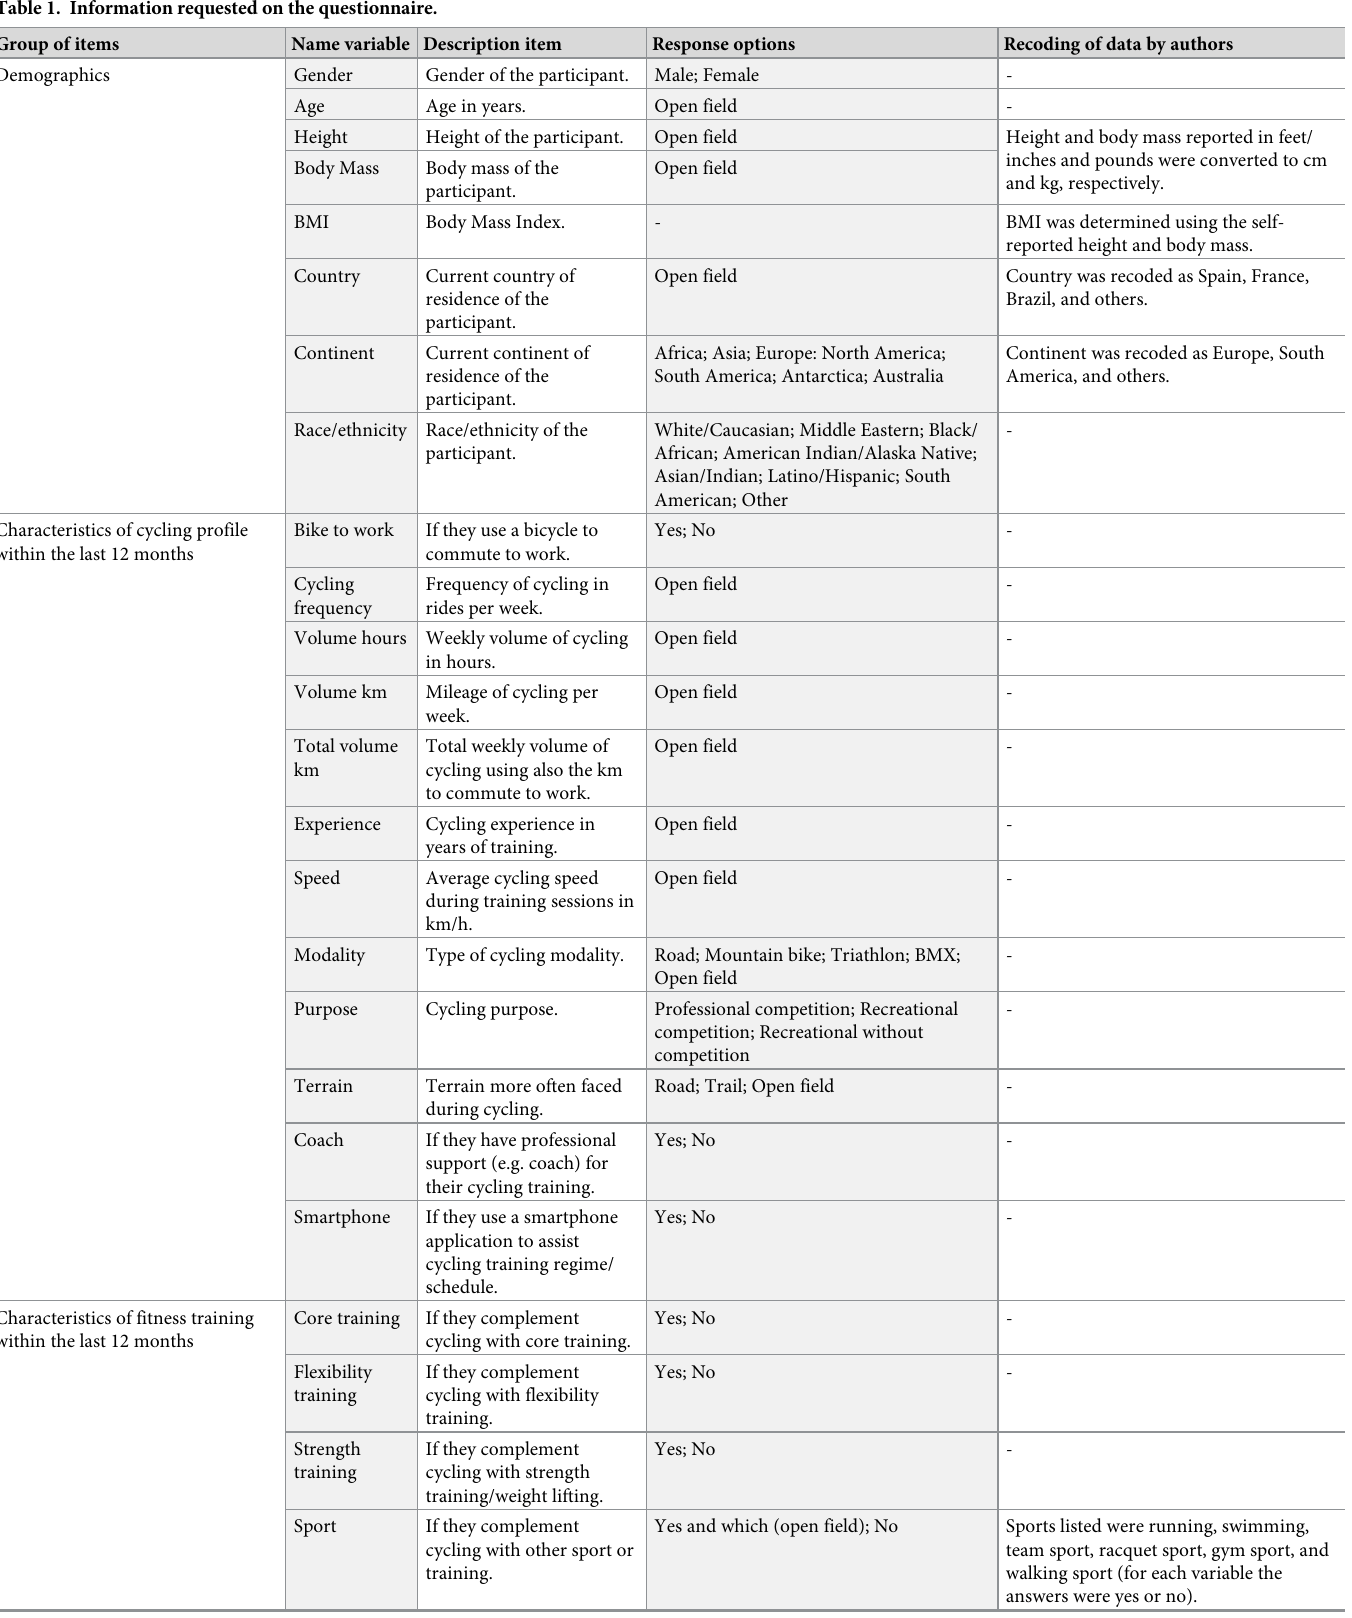
Table 1. Information requested on the questionnaire. Group of